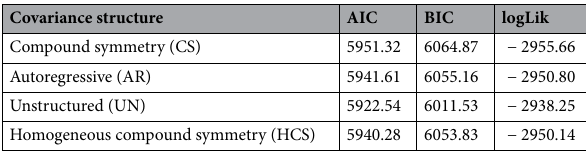
Table 1. Analysis for the selection of the best fitting covariance structure.